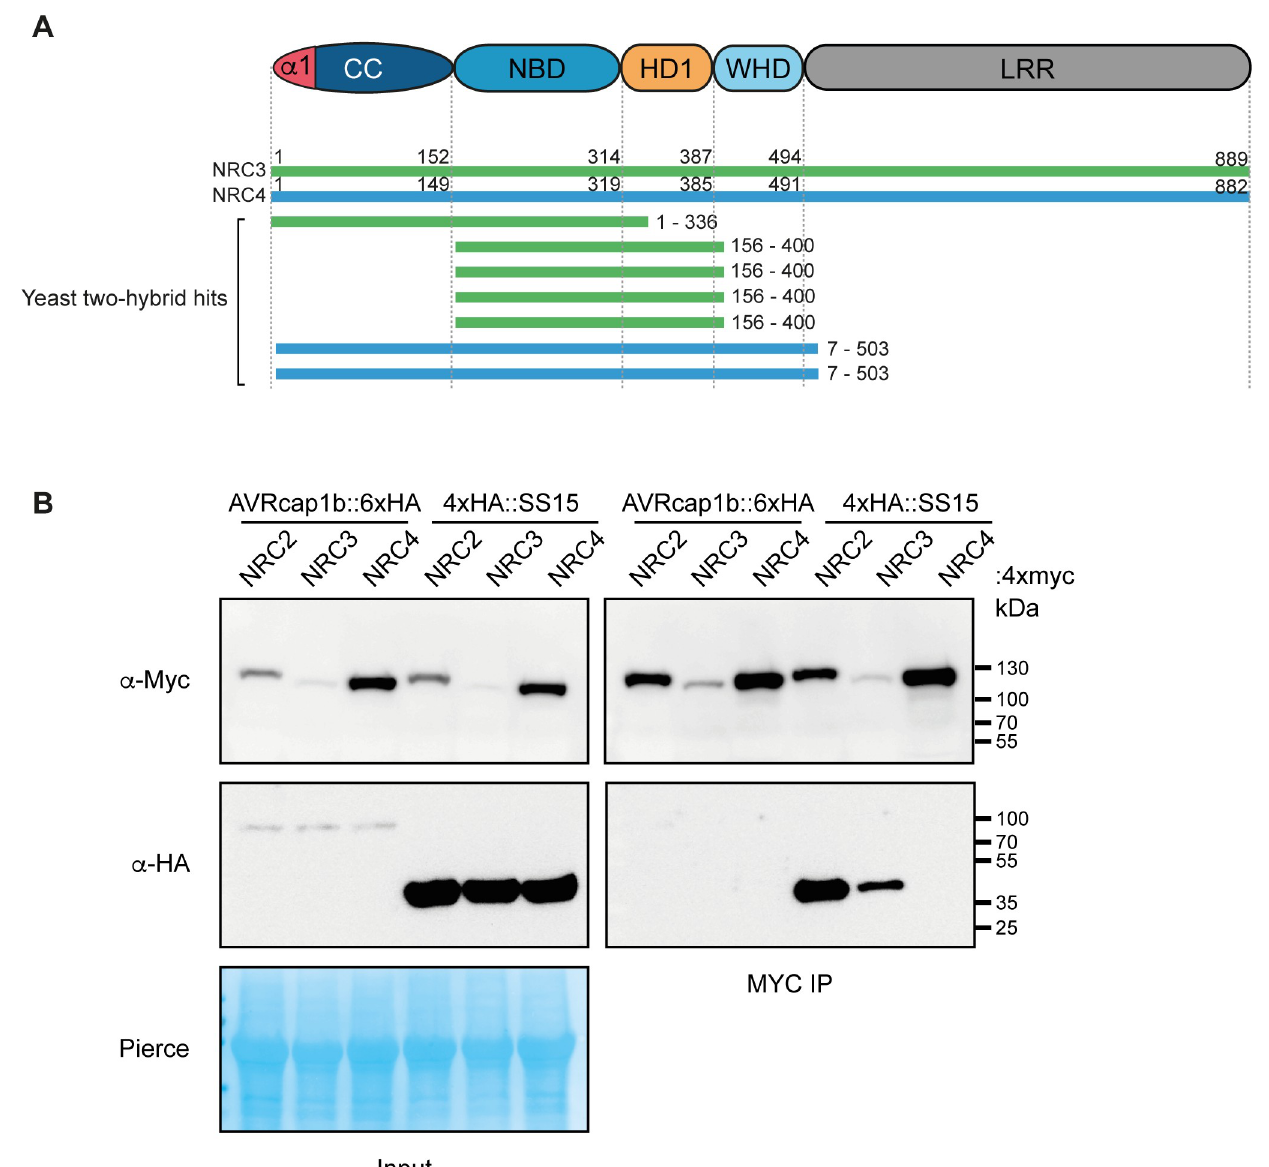
Fig 6. SS15, but not AVRcap1b, associates with NRCs in planta . (A) Schematic diagram of domain organisation of NRC proteins, showing Y2H hits from the Hybrigenics services screen (S3 Table). (B) CoIP experiment of C-terminally 4xmyc-tagged NRC2, NRC3, and NRC4 with C-terminally HA- tagged AVRcap1b::6xHA and N-terminally tagged 4xHA:SS15 (labelled above). Proteins obtained by coIP with MYC beads (MYC IP) and total protein extracts (input) were immunoblotted with the appropriate antisera labelled on the left. Approximate molecular weights (kDa) of the proteins are shown on the right. Rubisco loading control was carried out using Pierce staining. The experiment was performed more than 3 times under different pulldown conditions with similar results. CC, coiled-coil; coIP, co-immunoprecipitation; HD1, helical domain 1; LRR, leucine-rich repeat; NBD, nucleotide-binding domain; NRC, NLR required for cell death; WHD, winged helix domain; Y2H, yeast